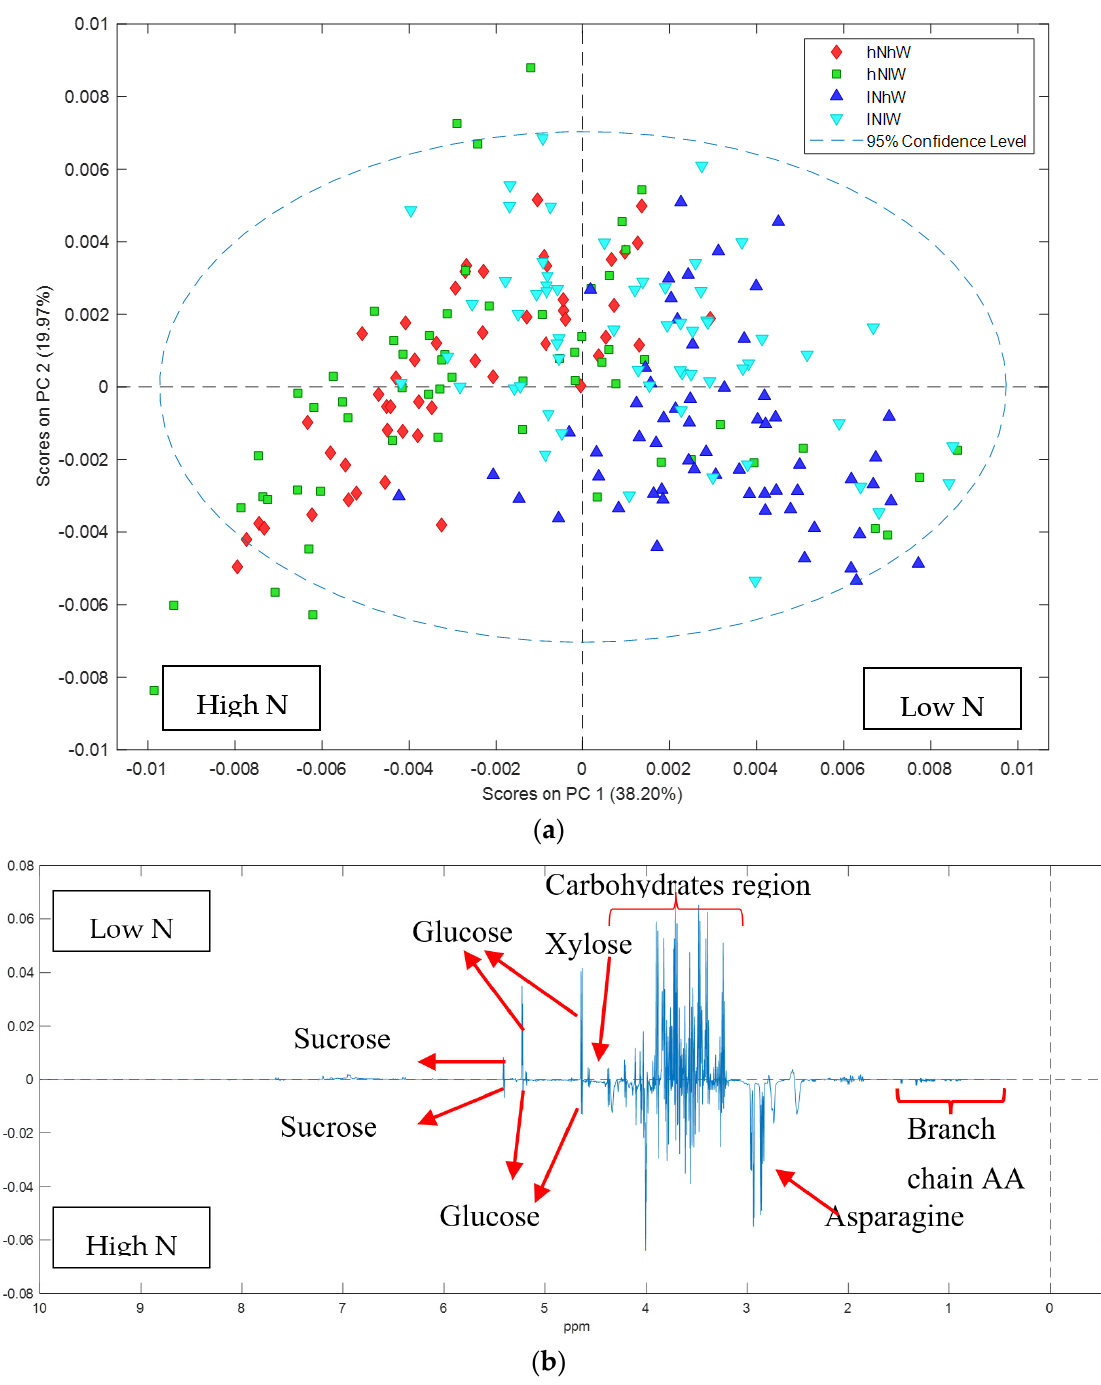
Figure 5. PCA score and loadings plots of 1 H NMR data of Carmel hull: ( a ) PCA scores plot showing clear separation of Carmel hull samples based on nitrogen treatment; ( b ) loadings plot of PC1 variables indicates that the high N treatment increased the amino acid